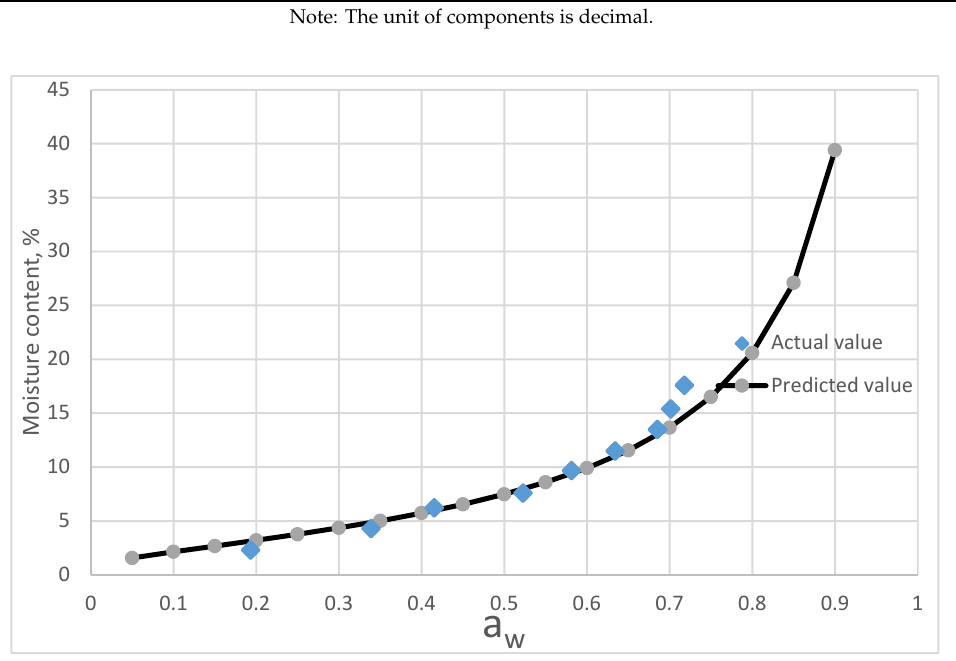
Figure 5. Comparing of the predictive values from the component model and the actual isotherm moisture of A. formosanus Hayata.